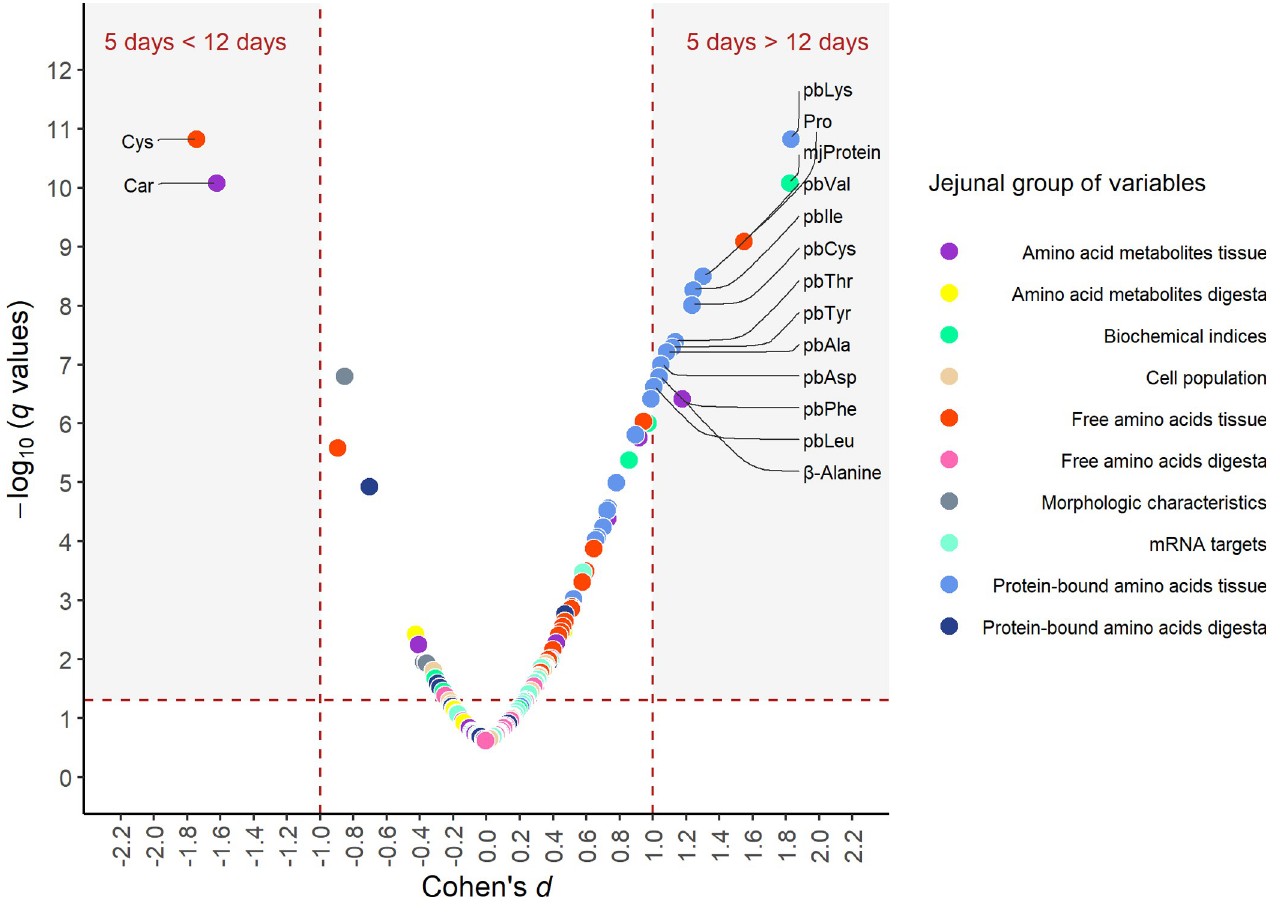
Fig 3. Volcano plot of jejunal variables analysed between 5 and 12 d old suckling piglets. Comparison of quantities of all 143 variables measured in 5 d and 12 d old suckling piglets. Q-values estimating the false discovery rate (FDR) were calculated for each variable from p-values of multiple Tukey-Kramer-tests comparing 5 d and 12 d old piglets. Effect sizes (Cohen’s d) were calculated for each variable based on the differences in estimated marginal means and standard deviations of 5 d versus 12 d old piglets. Differences are classified as being substantial (grey shaded area) if FDR is limited to 0.05 (q < 0.05) and if the effect size of Cohen’s d < 1 (5 d is smaller than 12 d) or Cohen’s d > 1 (5 d is larger than 12 d). The 16 variables meeting this condition are